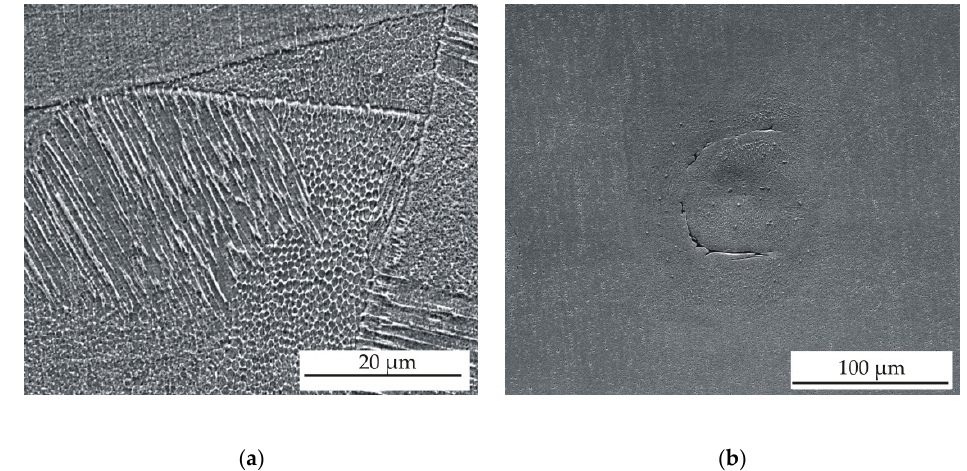
Figure 10. ( a ) SEM image of sample 5 after SLM and ( b ) SEM image of defect in sample 6, etched with Carpenter reagent.